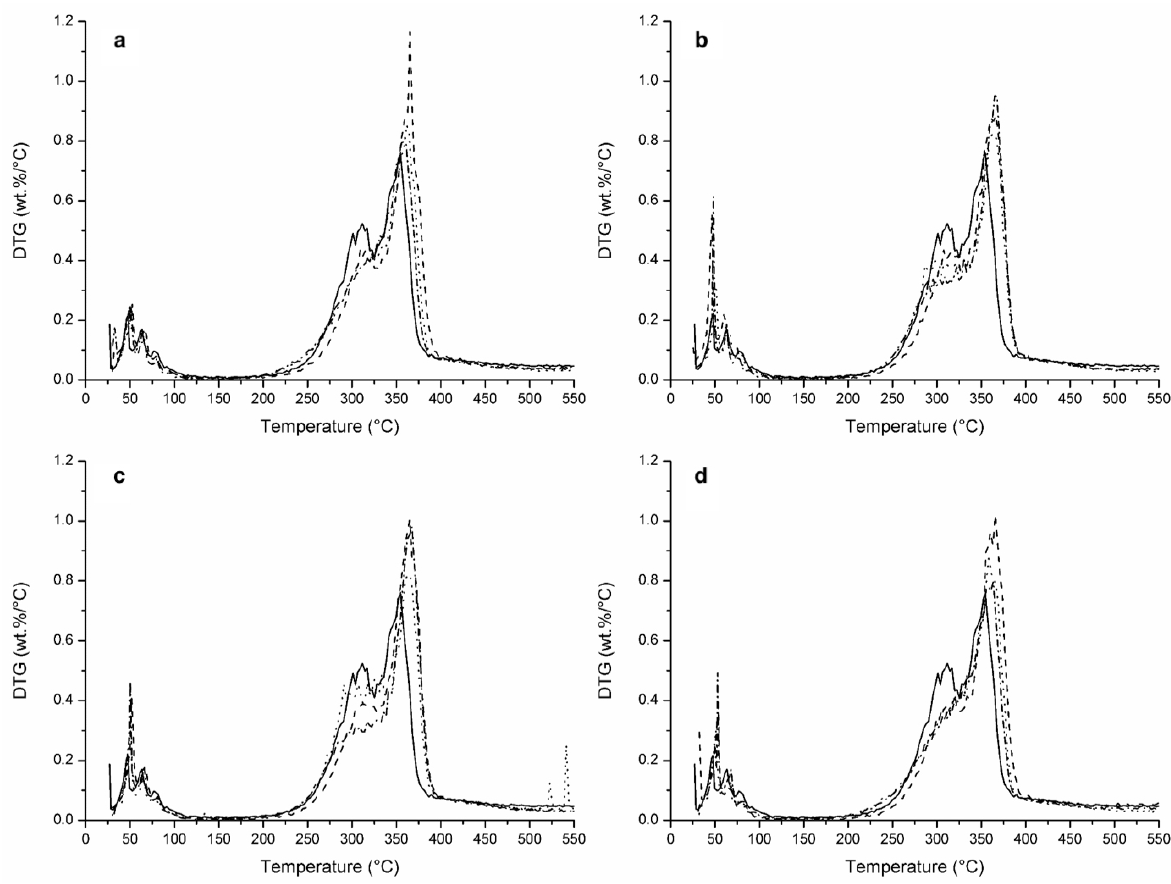
Figure 4. DTG of rice hull treated with [bmim][Ac] ( a and c ), and [bmim][Cl] ( b and d ), for 2 h ( a and b ), and 6 h ( c and d ). Legend: (—) untreated biomass, (----) IL 50 % and 75 °C, (. . . .) IL 100 % and 75 °C, and (-.-.-.) IL 100 % and 100